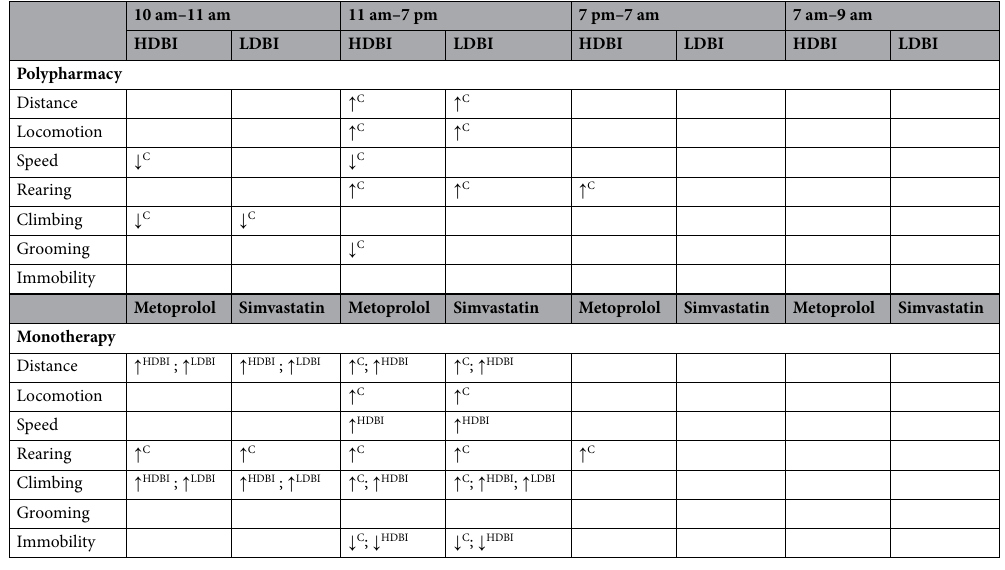
Table 2. Summary of the comparisons among all young mice. ↑ C , ↓ C : increase or decrease in treatment compared to control; ↑ HDBI , ↓ HDBI : increase or decrease in treatment compared to HDBI polypharmacy; ↑ LDBI , ↓ LDBI : increase or decrease in treatment compared to LDBI